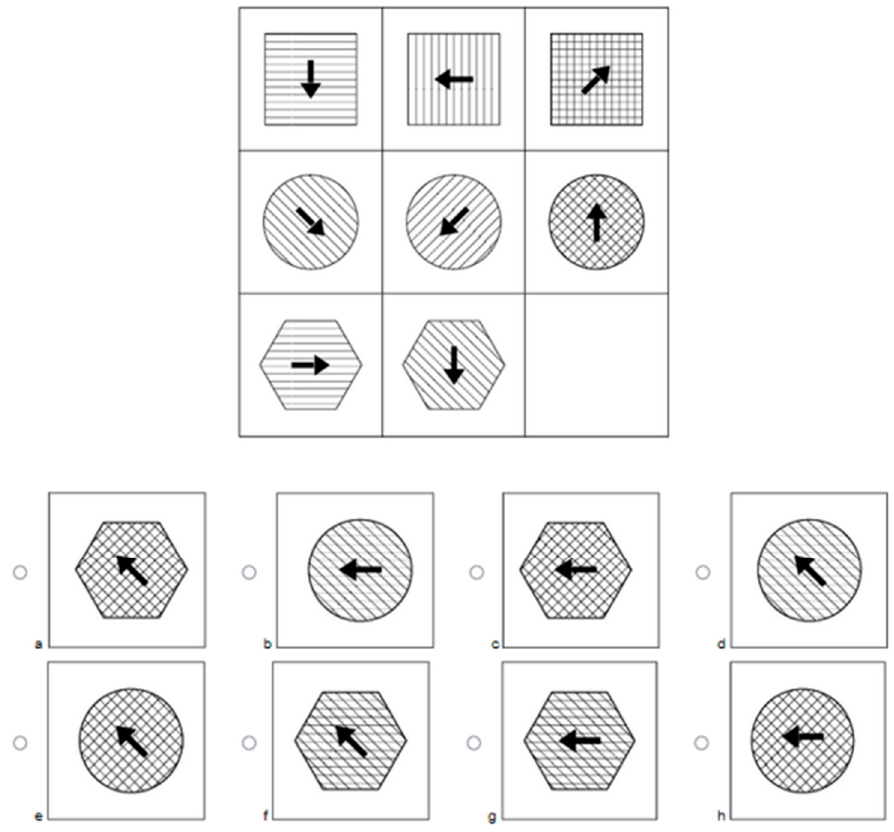
Figure 3. This example item features the three operations Identification, Addition, and Seriation. Response option f correctly follows all operations and hence completes the item stem.